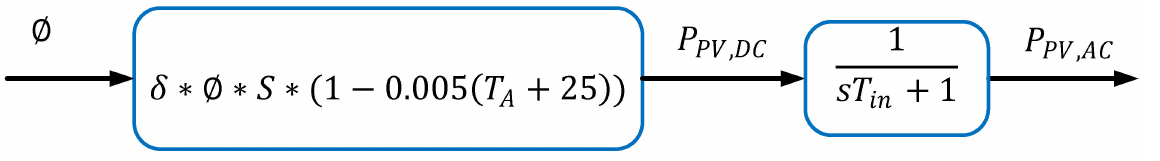
Figure 3. The solar irradiance model.